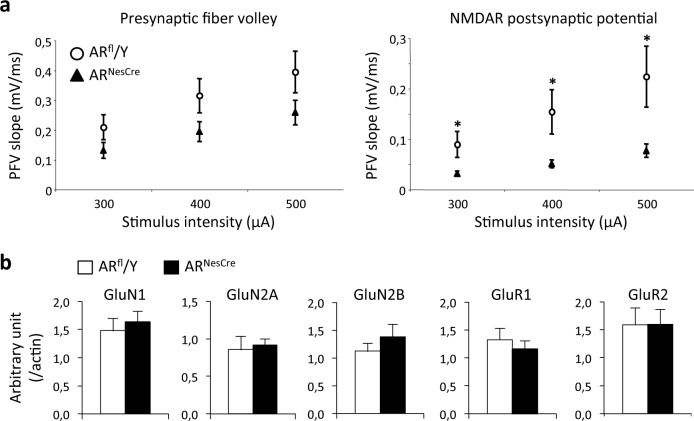
NMDAR-mediated synaptic activation in the hippocampal CA1 area of ARfl/Y and ARNesCre male mice.(a) Input/Output (I/O) curves of presynaptic fiber volleys (left) and NMDAR-mediated fEPSPs (right) in low-magnesium medium supplemented with 2,3-dioxo-6-nitro-1,2,3,4-tetrahydrobenzoquinoxaline-7-sulfonamide (12–13 slices from 8 males per genotype). PFV magnitude was not affected, whereas fEPSP values were significantly lower at all stimulus intensities in ARNesCre males (*p < 0.05). (b) Densitometric quantification of NMDAR (GluN1, GluN2A, GluN2B) and non-NMDAR (GluR1, GluR2) proteins normalized to ß-actin in the CA1 area (n = 6–8 males per genotype).